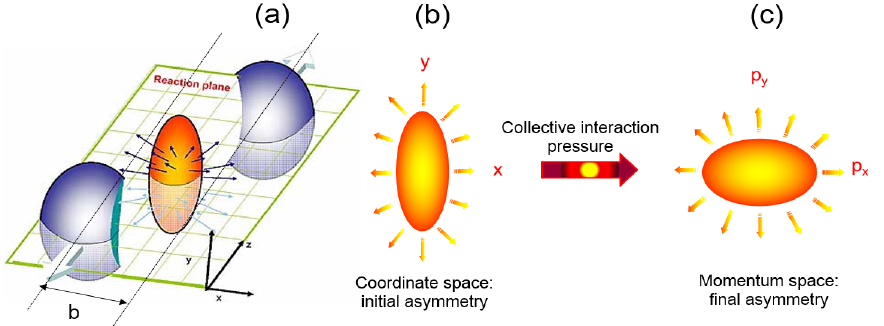
Figure 18. ( a ) A non-central collision of two nuclei leads to an almond-shaped interaction volume; ( b ) This initial spatial anisotropy with respect to the reaction plane translates via pressure gradients into ( c ) a momentum anisotropy of the produced particles. Reproduced from Ref.